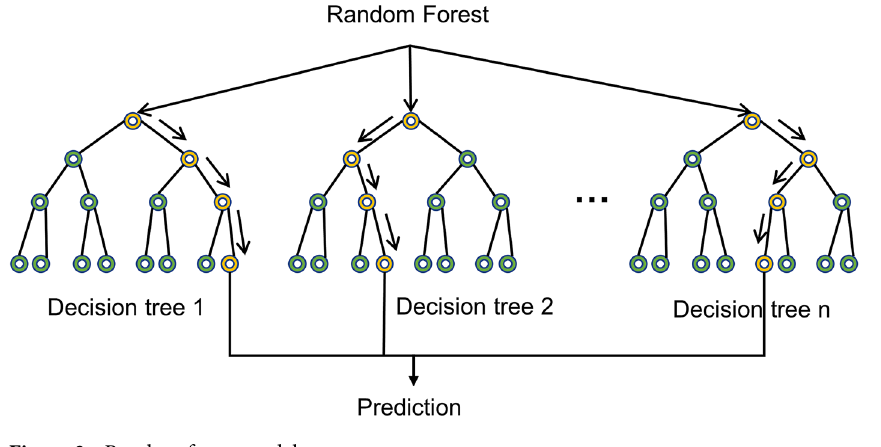
Figure 3. Random forest